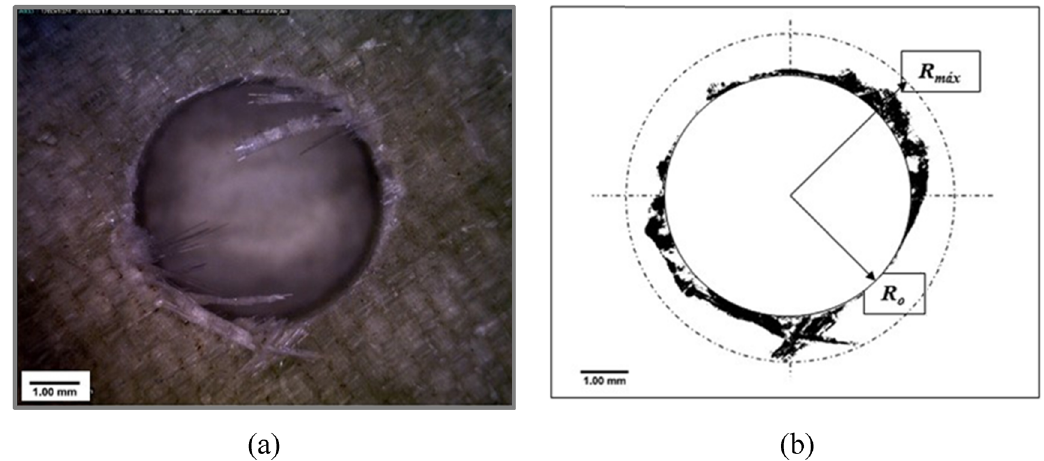
Figure 2: Output hole 1: ( a ) original image and ( b ) segmented image used for the calculation of F da